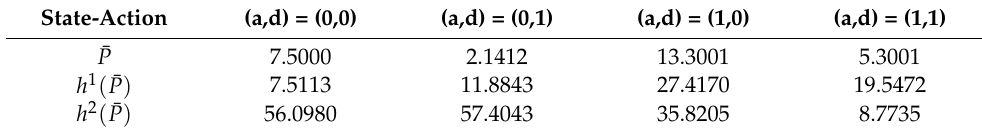
Table 5. Convergent Q -table based on Q -leaning, considering the game of sensor and attacker.